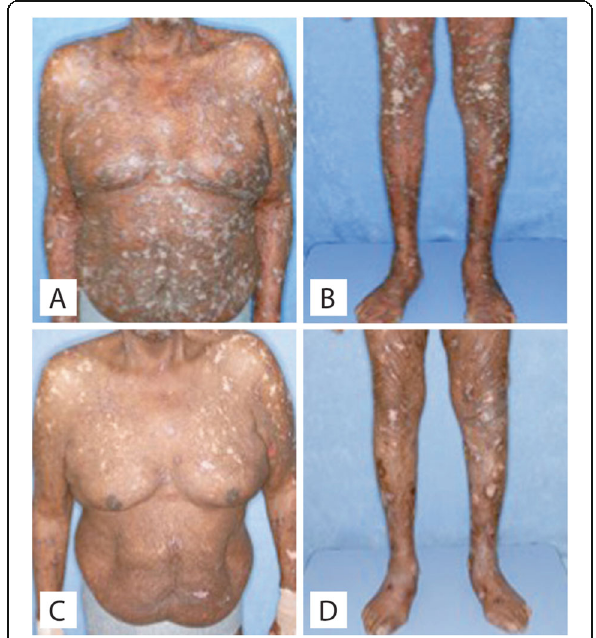
Fig. 6 Clinical photos of Case 2. a - b Upon presentation at our institution. Diffuse erythematous hypertrophic and ulcerated papules and plaques. c - d Improvement after therapy